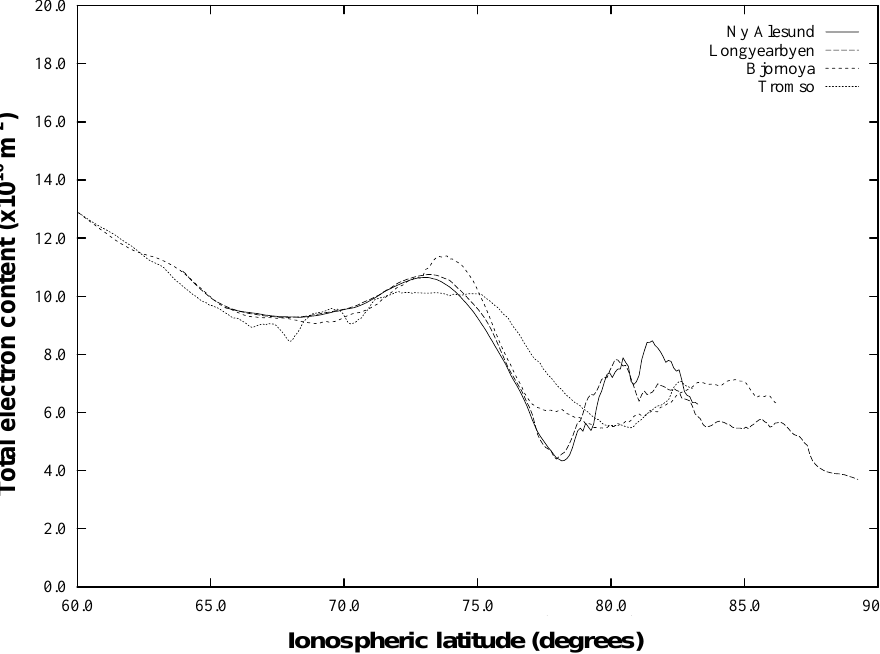
Fig. 7. Latitudinal variation in the equivalent vertical total electron content measured at four sites in northern Scandinavia during a satellite pass that crossed 75 ◦ N at 08:10 UT on 20 December